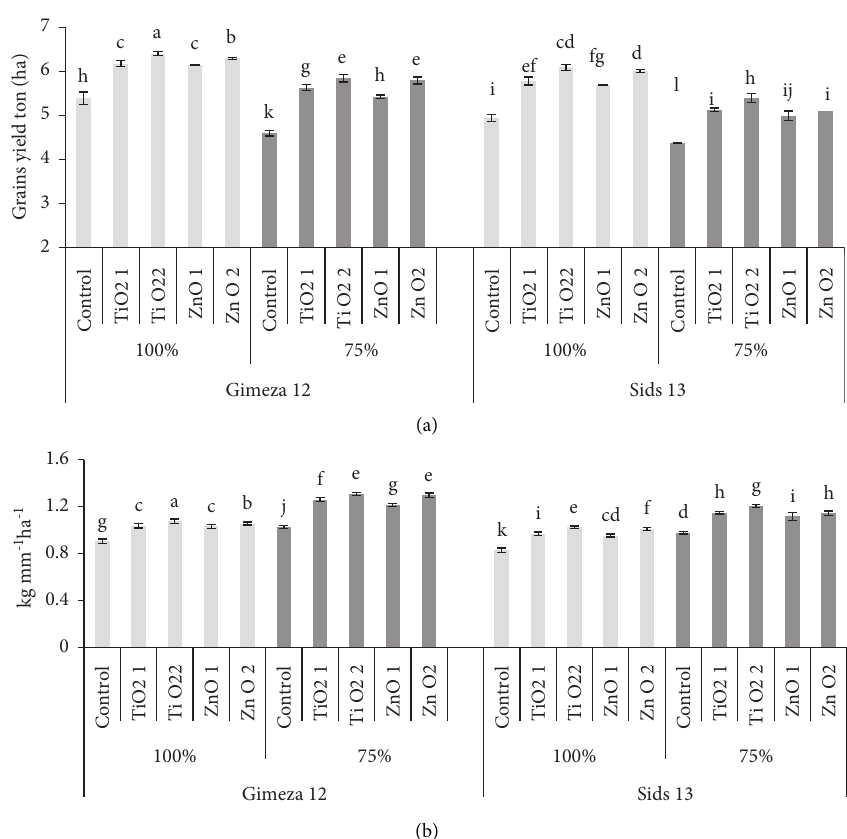
Figure 3: The effect of different concentrations of nano-TiO 2 or nano-ZnO (5 and 10mg/L) on grain yield (a) and water productivity (b) at harvest of both wheat cultivars (Gimeza 12 and Sids 13) subjected to different levels of water irrigation requirement (combined analysis of two seasons). TiO 2 1 � 5mg/L, TiO 2 2 � 10mg/L, ZnO 1 � 5mg/L, and ZnO 2 �